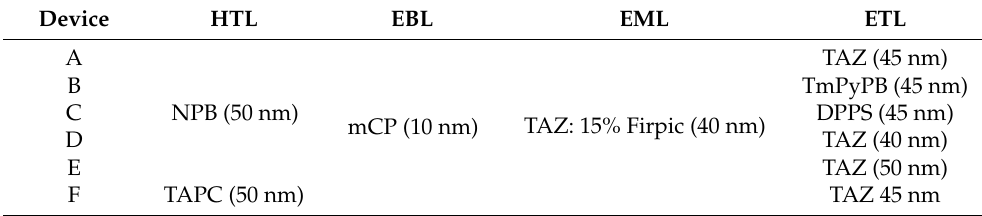
Figure 1. ( a ) Schematic device structure of blue phosphorescent organic light-emitting diodes (PHOLEDs) and energy band diagram of organic compounds of FIrpic, 3-(4-biphenyl-yl)-4-phenyl-5-(4-tert-butylphenyl)-1,2,4-triazole (TAZ), diphenyl-bis[4-(pyridin-3-yl)phenyl]silane (DPPS), diphenyl-bis[4-(pyridin-3-yl)phenyl]silane (DPPS) and 1,3,5-tri(m-pyrid-3-yl-phenyl)benzene (TmPyPB), mCP, 4,4 ′ -bis[N-1-naphthyl-N-phenyl-amino]biphenyl (NPB) and 4,4 ′ -bis[N-1-naphthyl-N-phenyl-amino]biphenyl (NPB), 1,1-bis[(di-4-tolylamino)phenyl]cyclohexane (TAPC), used in the blue PHOLEDs; ( b ) chemical structure of the organic compounds. Table 1. Device structures for blue PHOLEDs with various electron-transporting layers (ETLs) and hole-transporting layers (HTLs).